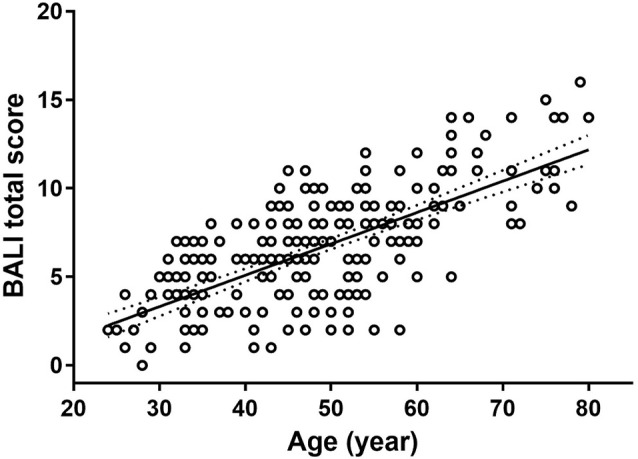
The Brain Atrophy and Lesion Index (BALI) as a function of age. Circles represent the raw data of the BALI total scores averaged by each year of age. Solid line represents the curve fitting using an exponential function; dotted lines represent the 95% confidence intervals. The relationship was described by a linear regression y = a+bx, where x is age, y is BALI score, a = −1.99 (−3.21 – −0.78); b = 0.18 (0.15–0.20); r = 0.69 (0.59–0.78), with 95% confidence interval given in the bracket. p < 0.001.